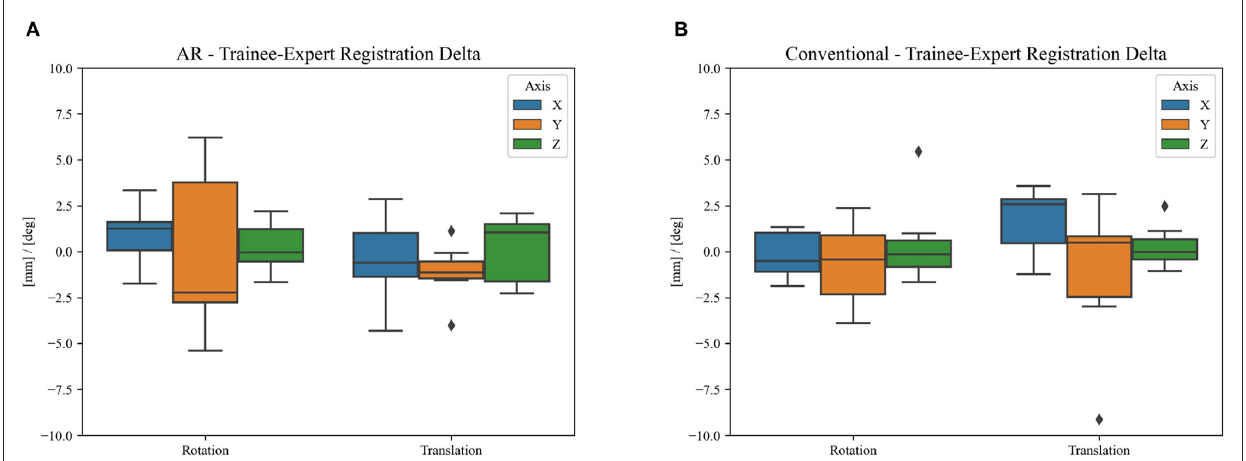
FIGURE10 Difference in clinical registration between expert and trainee investigators using (A) the proposed AR workflow and (B) the conventional neuronavigation workflow. The registration variability between expert and non-expert surgeons using the proposed AR method was not statistically different ( p = 0.14) when compared to the traditional neuronavigation system. The black diamonds represent outlier data.